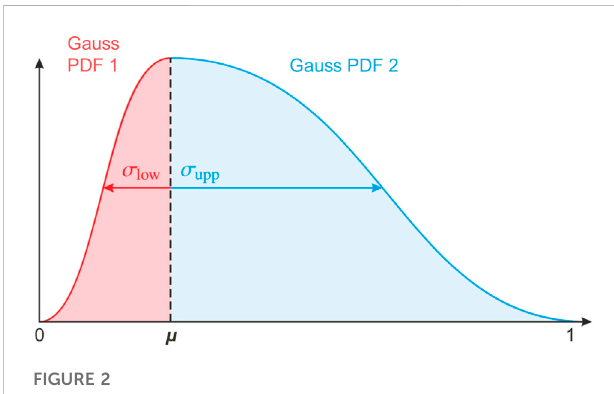
FIGURE 2 Asymmetrical Gaussian distribution used for soil moisture